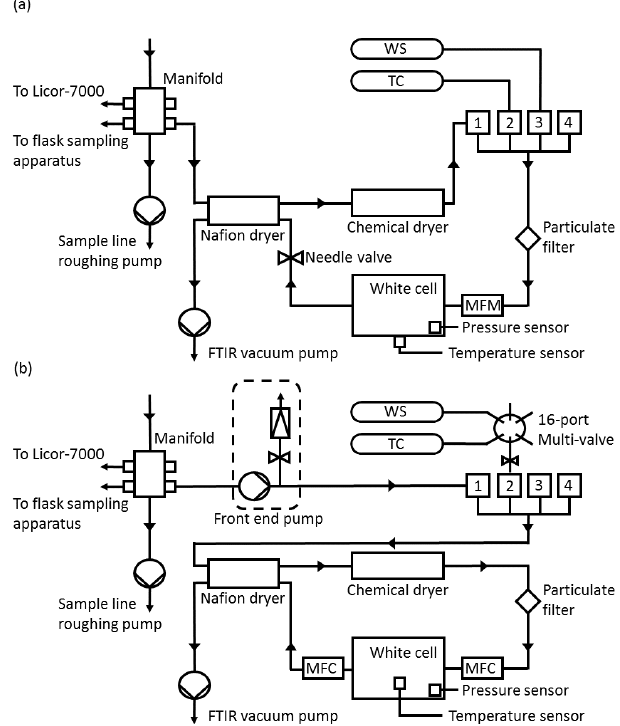
Figure 2. (a) Simplified Lauder FTIR gas schematic prior to up- grades. WS is the working standard, TC is the target cylinder and MFM is the mass flow metre. (b) Schematic of FTIR gas handling after the September 2013 upgrades. MFC is the mass flow con-